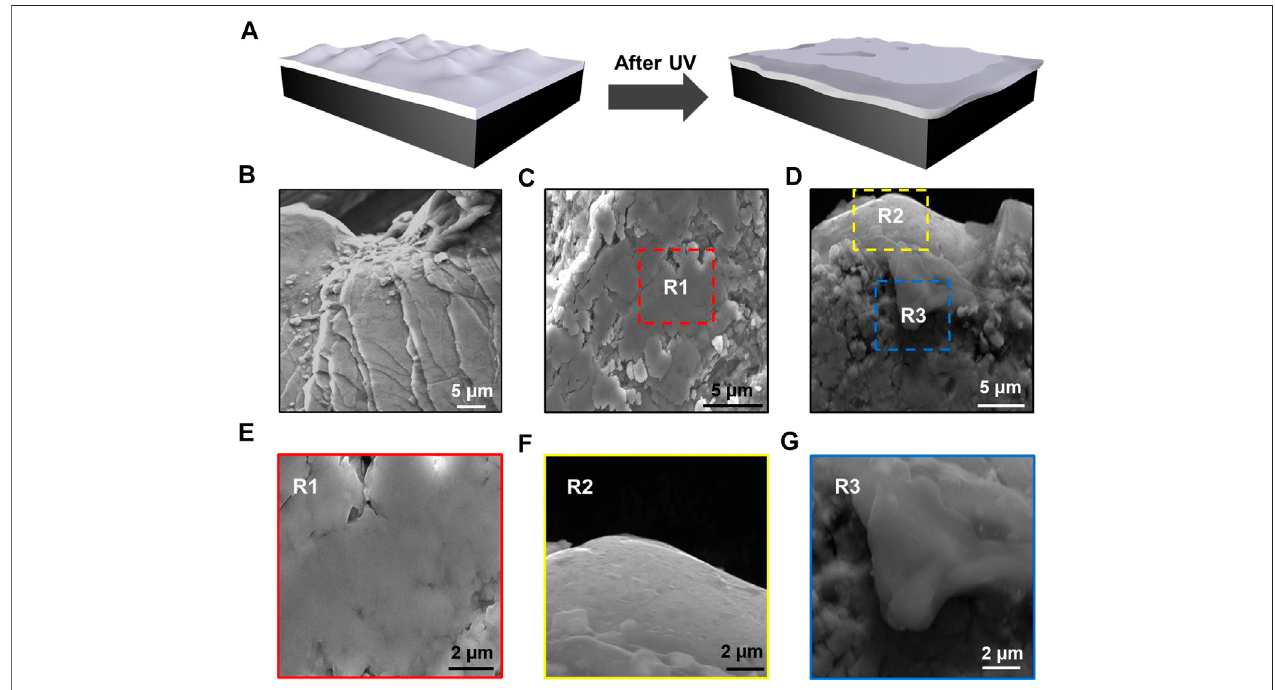
FIGURE 5 | Sample surface morphology. (A) Schematic diagram of sample microsurface changes before and after UV. (B) Typical extrusion deformation morphology of amorphous alloy. (C) and (D) SEM morphology of the sample surface after UV. (E – G) are enlarged views of the areas corresponding to those in (C) and (D)